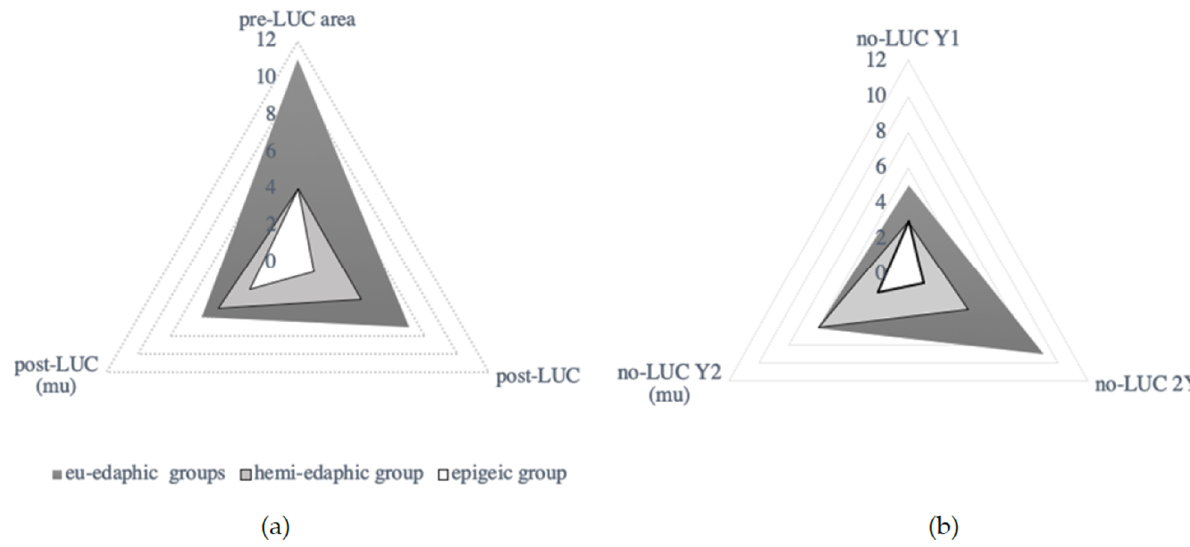
Figure 5. Composition of microarthropod communities by three morpho-functional levels in the different areas: ( a ) LUC area and ( b ) no-LUC area, by mulching (mu) effect.